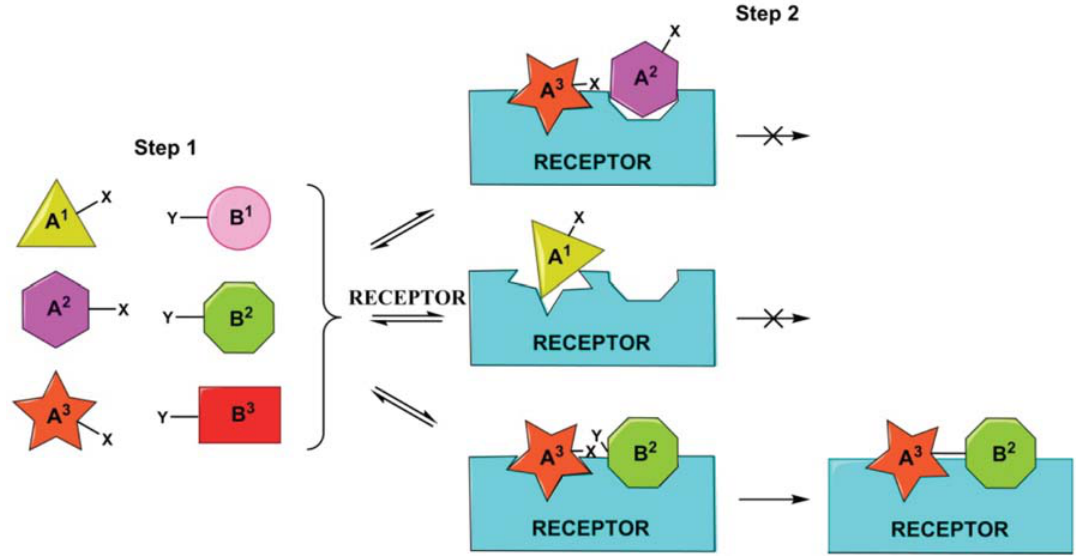
Figure 6. Receptor-accelerated synthesis for hit discovery and optimization. Products are created from blocks properly stabilized within the